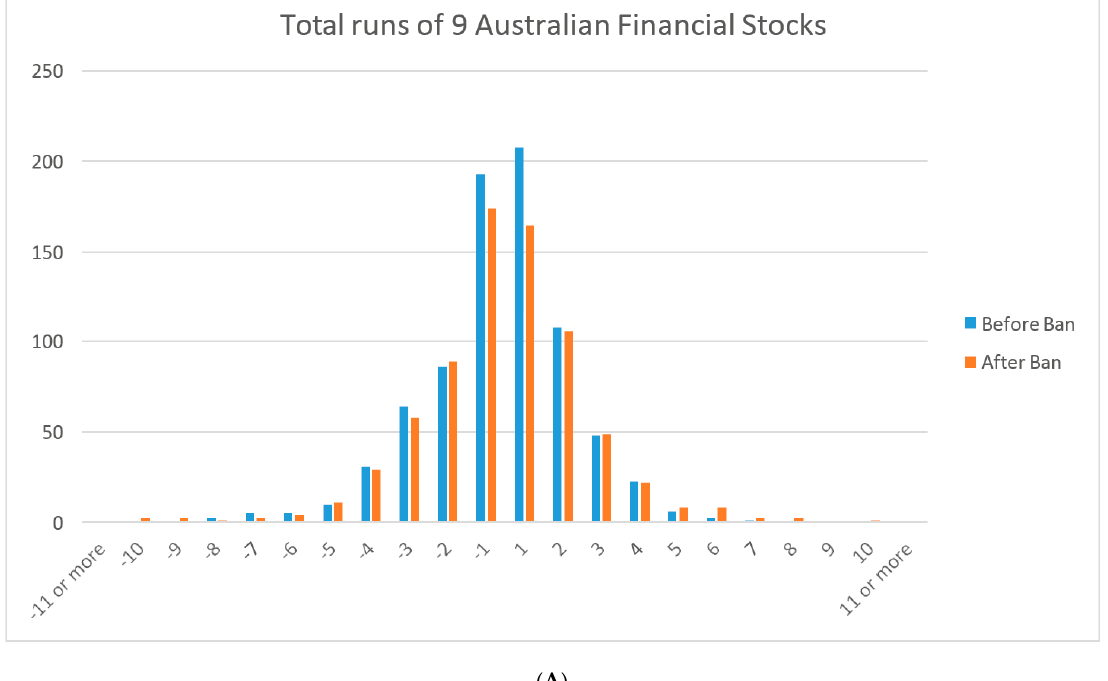
( B ) Figure 4. ( A ) Runs Distribution for Australian Stock Returns Before and After Short Selling Ban; ( B ) Tails of the Runs Distribution for Australian Stock Returns (|n| ≥ 5 days). 4. Concluding Remarks Regulators for a number of national exchanges have banned the practice of short selling. This is often the case in emerging markets. Whether the reason is fear of market manipulation or simply the lack of an institutional framework to borrow shares, a short selling ban potentially impedes the impounding of information in market prices. Previous studies typically consider the effect of a short selling ban on price discovery by examining price dynamics before and after changes in short selling regulations. However, for many